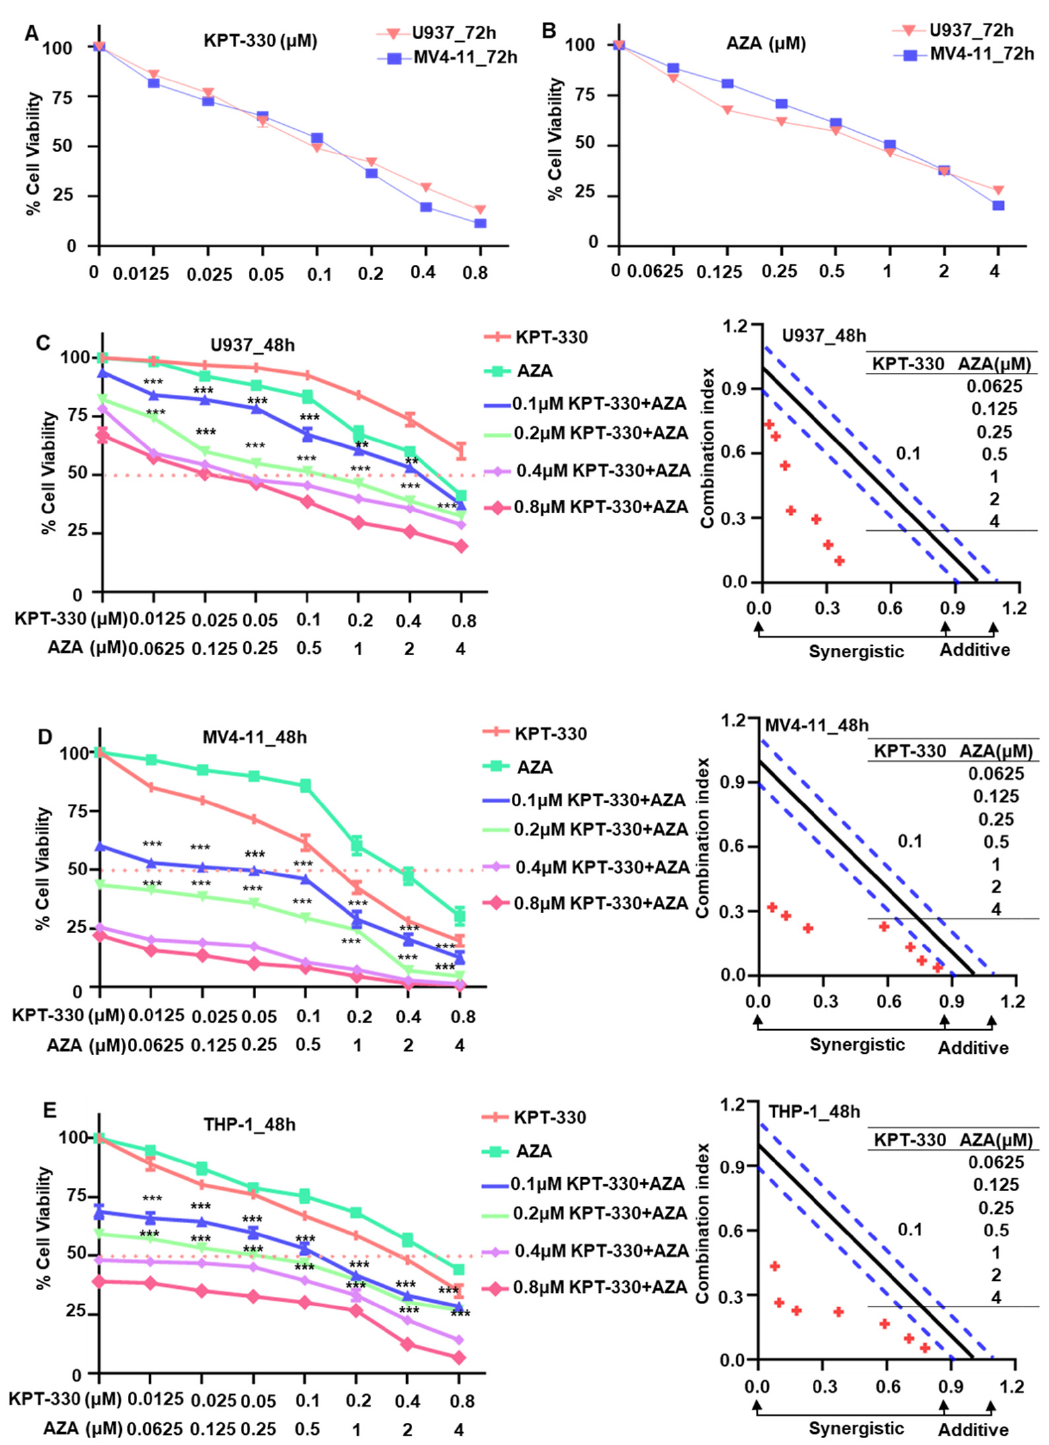
Figure 1. KPT-330 combined with AZA synergistically inhibited AML cell growth. ( A ) Cell proliferation assay result (dose-dependent curve) for KPT-330 in U937 and MV4-11 for 72 h. ( B ) Cell proliferation assay result (dose-dependent curve) for AZA in U937 and MV4-11 for 72 h. ( C ) Synergistic effect of KPT-330 with various doses of AZA on cell proliferation arrest and CalcuSyn analysis in U937 cells. ( D ) Synergistic effect of KPT-330 with various doses of AZA on cell proliferation arrest and CalcuSyn analysis in MV4-11 cells. ( E ) Synergistic effect of KPT-330 with various doses of AZA on cell proliferation arrest and CalcuSyn analysis in THP-1 cells. “……” indicates IC50, “ ---- ” indicates the range of synergies. ** p < 0.01, *** p < 0.001.